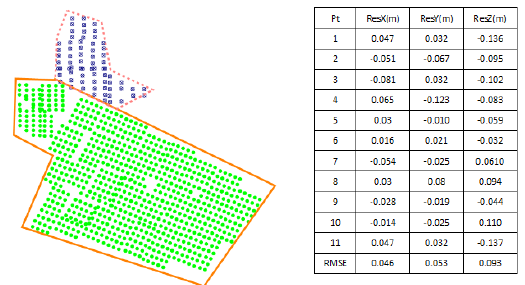
Figure 6. The left is the layout of the whole NUS image blocks.